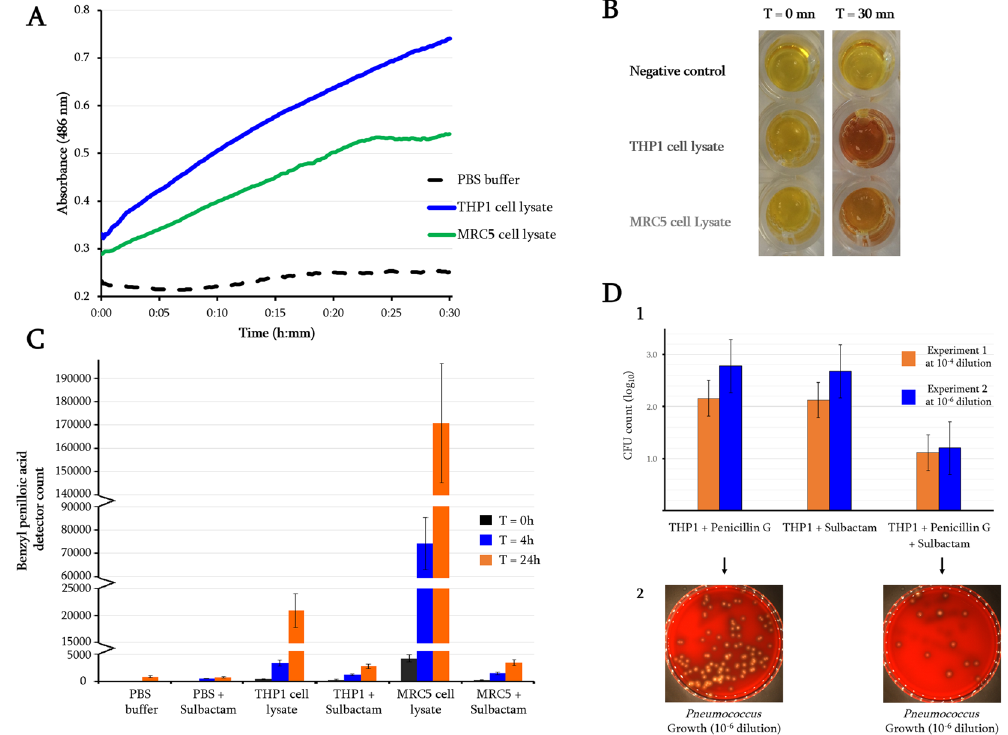
Figure 1. Beta-lactamase activity detected in human cell cultures. ( A ) Spectrophotometric assay of nitrocefin degradation in the presence of THP1 and MRC5 cell lysates monitored for 30 minutes by monitoring absorbance at 486 nm; ( B ) Nitrocefin solutions with added THP1 and MRC5 cell lysates or PBS (used as negative control), incubated at 25 °C and observed after 30 minutes. The appearance of a red-coloured product indicates positive β -lactamase activity, while a constant yellow colour indicates no activity; ( C ) LC/MS average detector counts of metabolite benzyl penilloic acid monitored during 24 hours. Penicillin G was added in the presence of human cell lysates (THP1 and MRC5) in the presence or absence of sulbactam; ( D ) determination of the growth of highly penicillin-susceptible Pneumococcus within human THP1 cells in the presence of penicillin G or sulbactam alone, and in the presence of both. ( D1 ) CFU count (log 10 ) of the Pneumococcus strain under the three different conditions after 24 h incubation in THP1 cells. ( D2 ) Bacterial colonies resulting from THP1 cell lysis grown on agar plates and observed after 24 hours. The Pneumococcus strain grew more easily within THP1 cells, despite the presence of penicillin G, than when sulbactam was